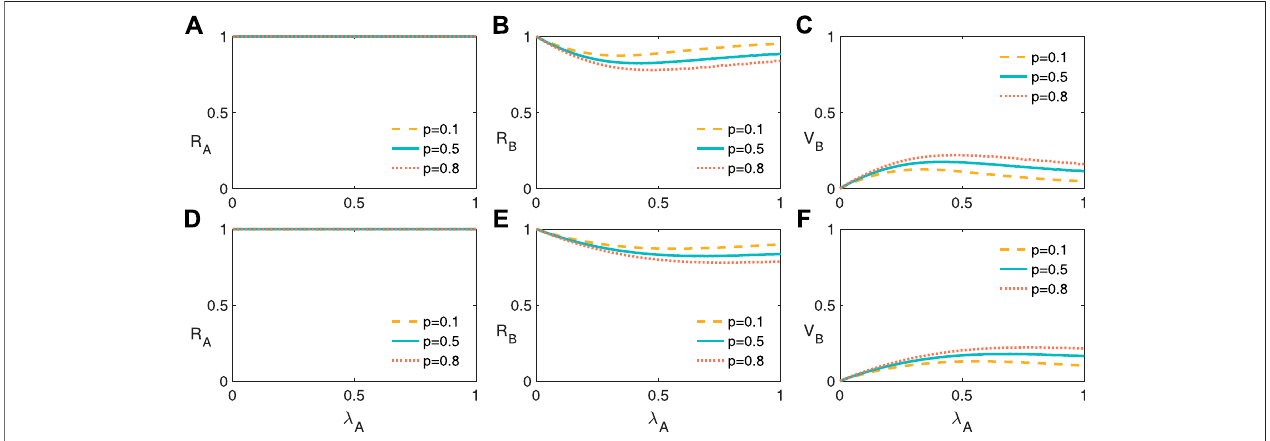
FIGURE 2 | (Color online) The fi nancial risk spreading on two-layer networks for a given values of fi nancial risk transmission probability. Final information spreading size R A (A) , fi nal fi nancial risk spreading size R B (B) , and vaccination size R B (C) versus information transmission probability λ A with fi nancial risk transmission probability λ B =0.5. R A (D) , R B (B) ,and R B (C) versus φ = 0.9.